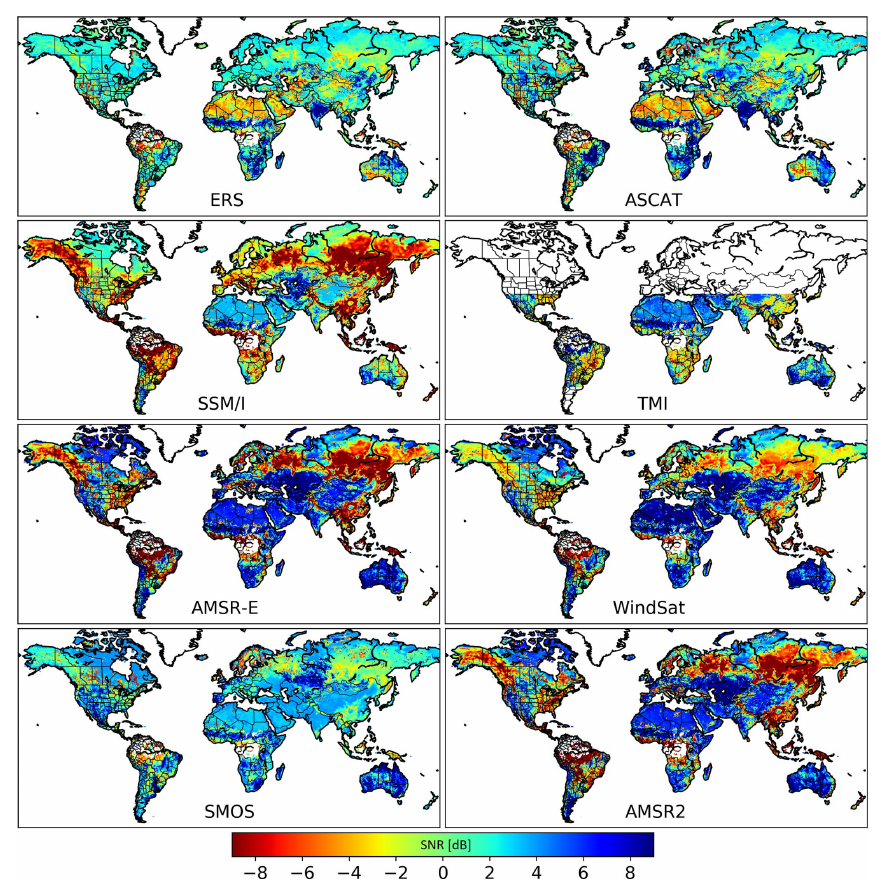
Figure 7. SNR (in decibel units) of all L2 input products with uncertainties estimated from TCA and the VOD regression.